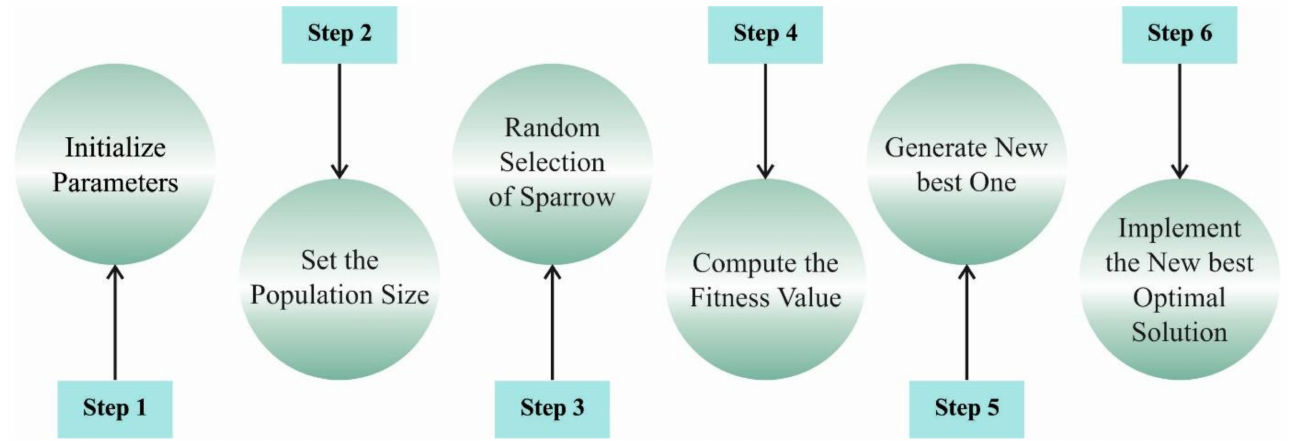
Figure 2. Steps involved in the SSO algorithm.